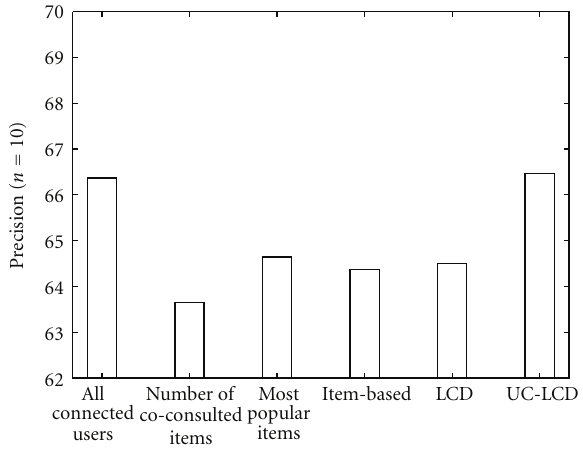
Figure 5: Precision values on Jester dataset for classical approaches for neighbors selection when ratings are not available.